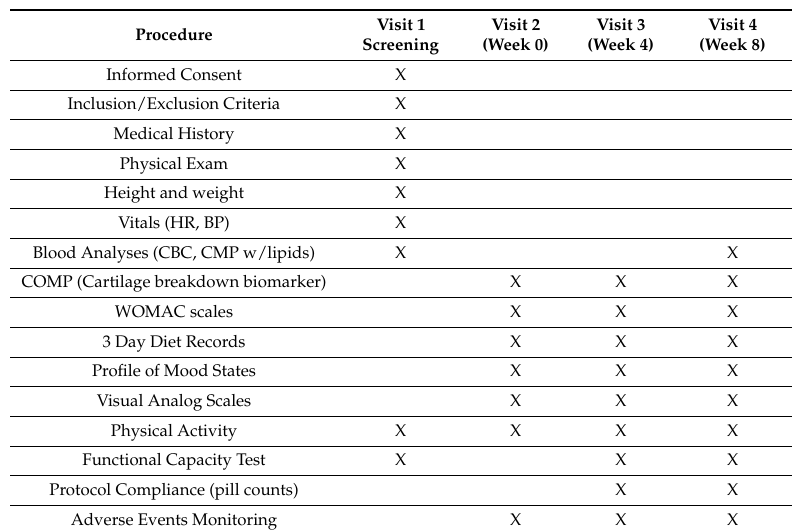
Table 1. Overview of Research